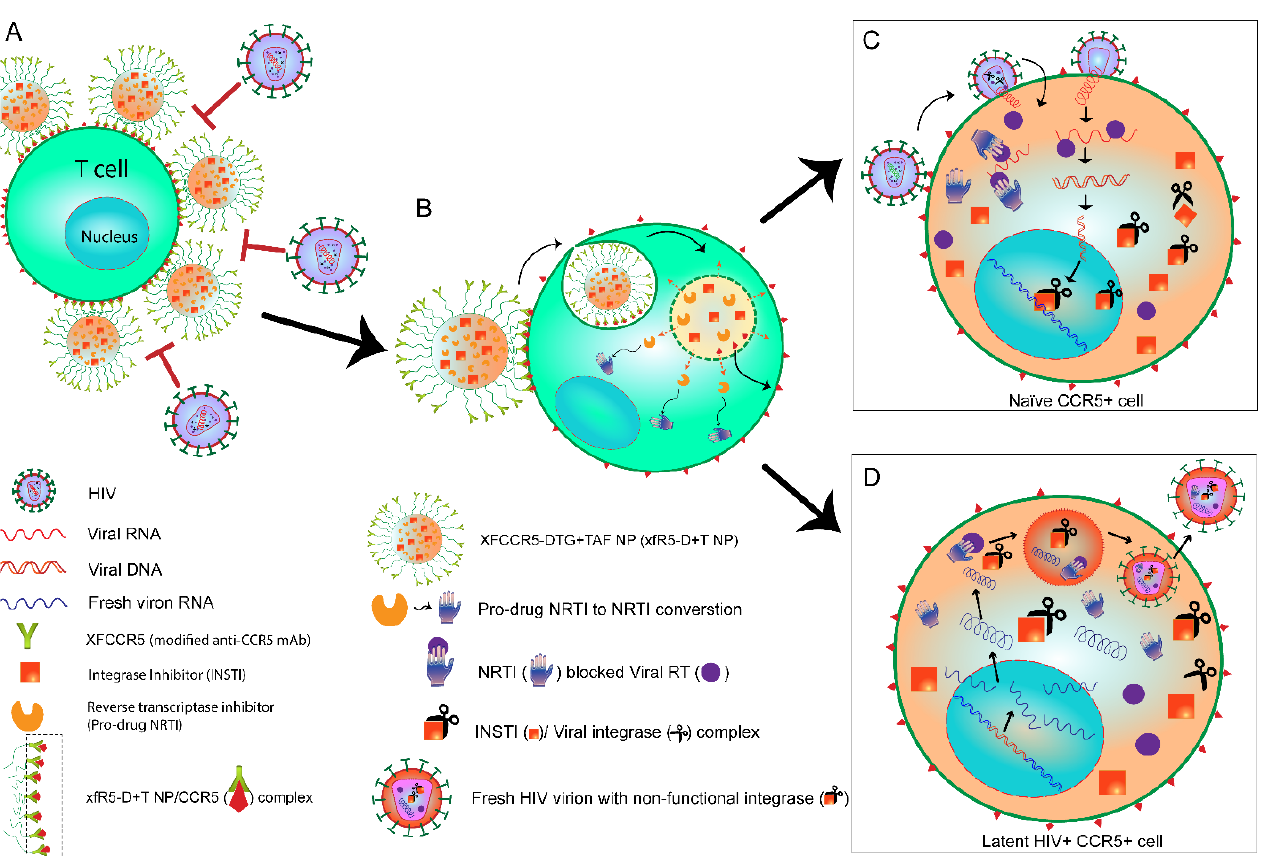
Figure 1. Schematic diagram explaining the dual-action strategy of targeted cARV-nanoformulation. ( A ) The first level of protection: Anti-CCR5 mAb+ ARVs loaded NP bound on the T-cell surface via CCR5 receptor (xfR5-D+T NP/CCR5 complex) blocks HIV interaction with CCR5 on the T-cell surface by two approaches, i.e., first, by blocking HIV from CCR5 binding and the second, providing steric hindrance to HIV virions due to nanoformulation crowding on T-cell surface (red block arrows) [30]. ( B ) The xfR5 D+T NP/CCR5 complex triggers the CCR5 trafficking pathway due to anti-CCR5 mAb binding with the CCR5+ T-cells [31] , leading to the internalization of xfR5 D+T NP. Within the endosome, the low pH induces the degradation of polymeric NPs, leading to the release of DTG (INSTI)and TAF (NRTI) into the cytoplasm. The second level of protection: the presence of an intercellular pool of TFV di-phosphates and DTG to prevent ( C ) naive cell HIV infection. ( D ) The latently HIV+ cells with free intracellular high-affinity DTG (INSTI), will bind with fresh integrase enzymes produced during the reactivation stage, resulting in a non-functional INSTI/integrase complex; therefore, fresh HIV virions thus produced will be with non-functional INSTIs, and, fresh virion will not be able to integrate viral DNA into the host genome.